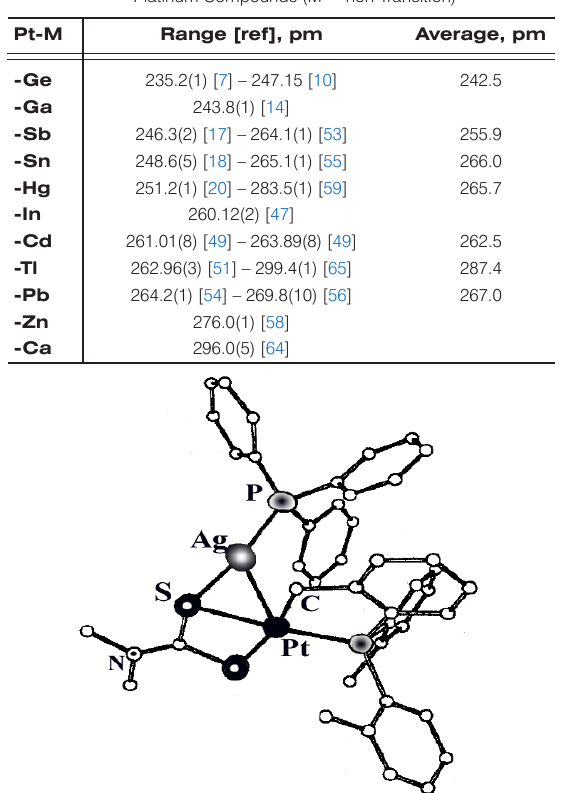
Figure 4. Structure of [( η 2 -mppm)Pt(μ- η 2 -S